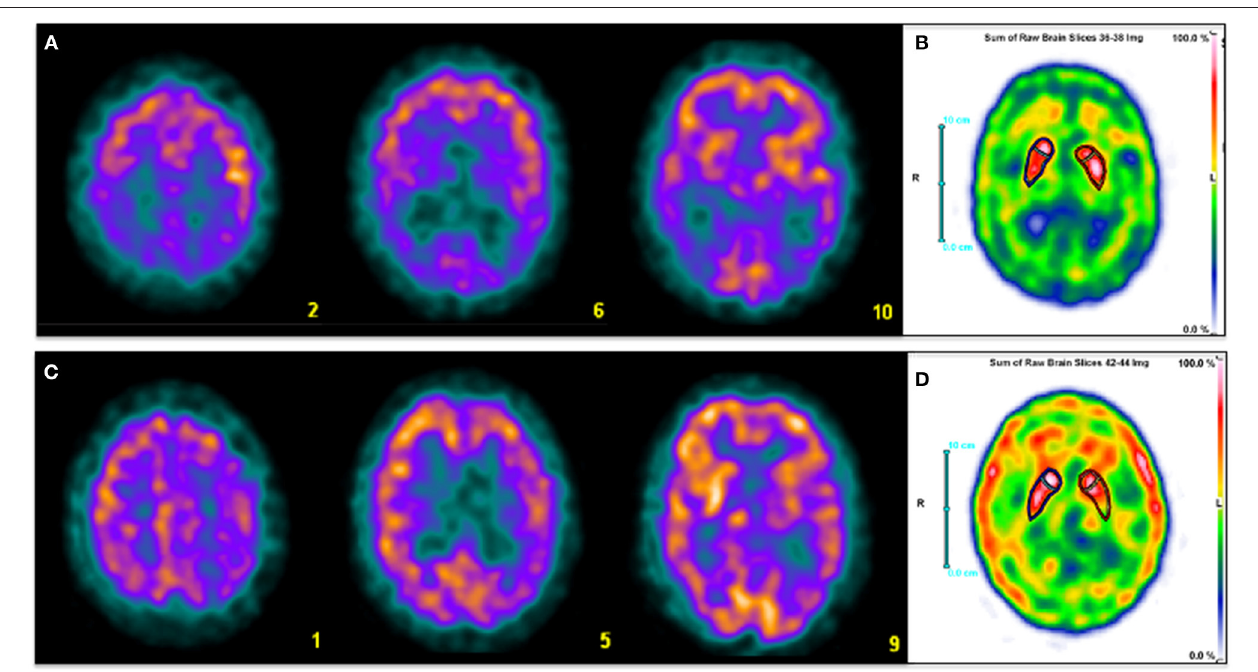
FIGURE 1 | Three selected transaxial slices of the perfusion SPECT (A,C) and a sum of three consecutive axial slices at the level of basal ganglia of DAT SPECT (C,D) of two patients referred for clinical evaluation of cognitive impairment. Superior row corresponds to a 59-year-old man with fluctuating cognitive impairment with frontal-subcortical profile in the neuropsychological examination. A typical pattern of LBD is depicted, with severe bilateral posterior parietotemporal and occipital hypoperfusion (A) . DAT imaging shows mildly reduced presynaptic dopamine transmission in right putamen and left caudate nucleus (B) . Inferior row shows a 63 year-old man with amnestic cognitive impairment and right extra-pyramidal signs. Diffuse hypoperfusion involving left parietal, frontal and temporal cortex, ipsilateral basal ganglia and thalamus (C) is associated with reduced left striatal dopamine transmission with posterior putamen predominance (D) . Findings are consistent with CBD. Clinical diagnosis was made based on perfusion SPECT in both patients. DAT SPECT images were performed later for academic